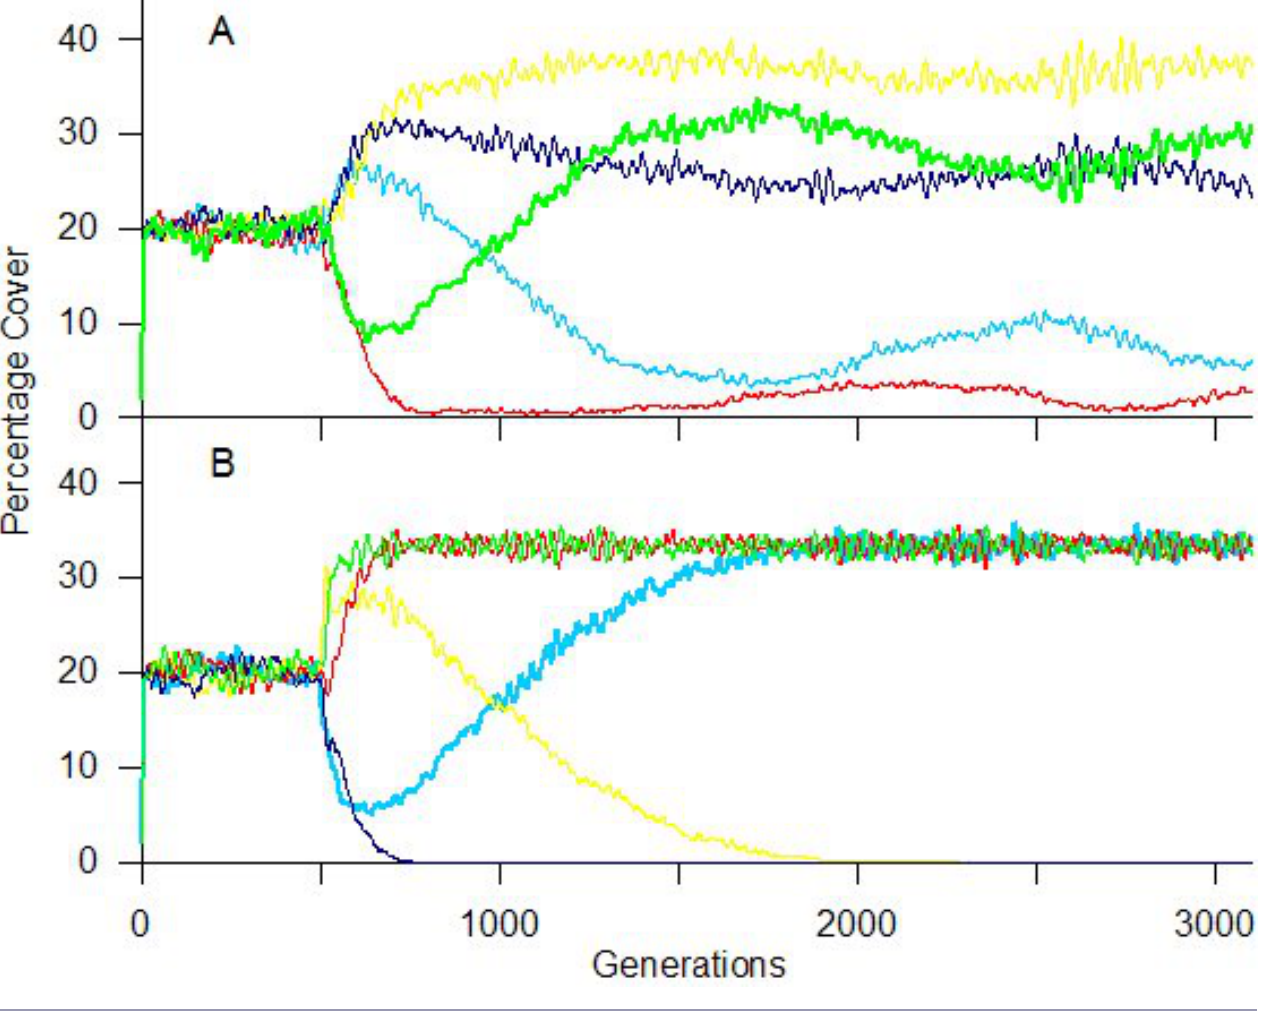
Fig. 2. Dynamics of a five-species community described by a symmetrical interaction network such that S > S , S ; S > S , S ; … ; S > S , S where “>” indicates overgrowth. Initially all species have 1 2 3 2 3 4 5 1 2 identical growth rates, and the likelihood of a species S overgrowing S (as defined by the interaction i j matrix) is unity. However, at 500 generations a shift in the “environment” is introduced. In (A) the growth rate of S drops to 75% of that of S -S , whereas in (B) growth rates are unaffected but the 5 1 4 interaction between S and S becomes reversible such that S wins in 60% of cases whereas S 1 2 1 40% of cases. S = light blue; S = yellow; S = red; S = dark blue; S = green. Bold lines (green in A, 1 2 3 4 5 light blue in B) indicate species analyzed to estimate CLSs (see Figs. 3,